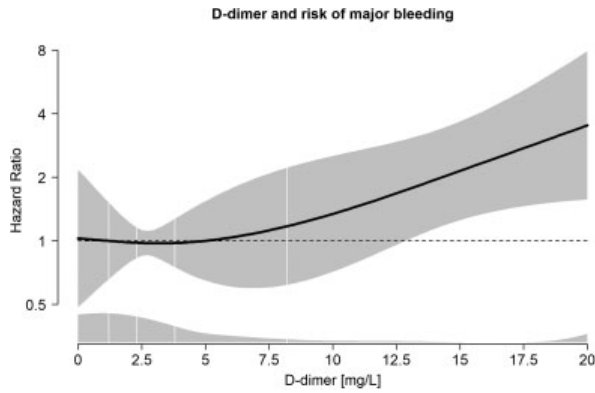
Fig. 2 The risk of major bleeding (MB) as a function of D-dimer adjusted for age, sex, and planned treatment duration in a generalized additive regression model. The solid line shows hazard ratios (HRs), enclosed by shaded area showing 95% con fi dence intervals. The distribution of D-dimer is shown as density plots at the bottom, and in quintiles at the vertical